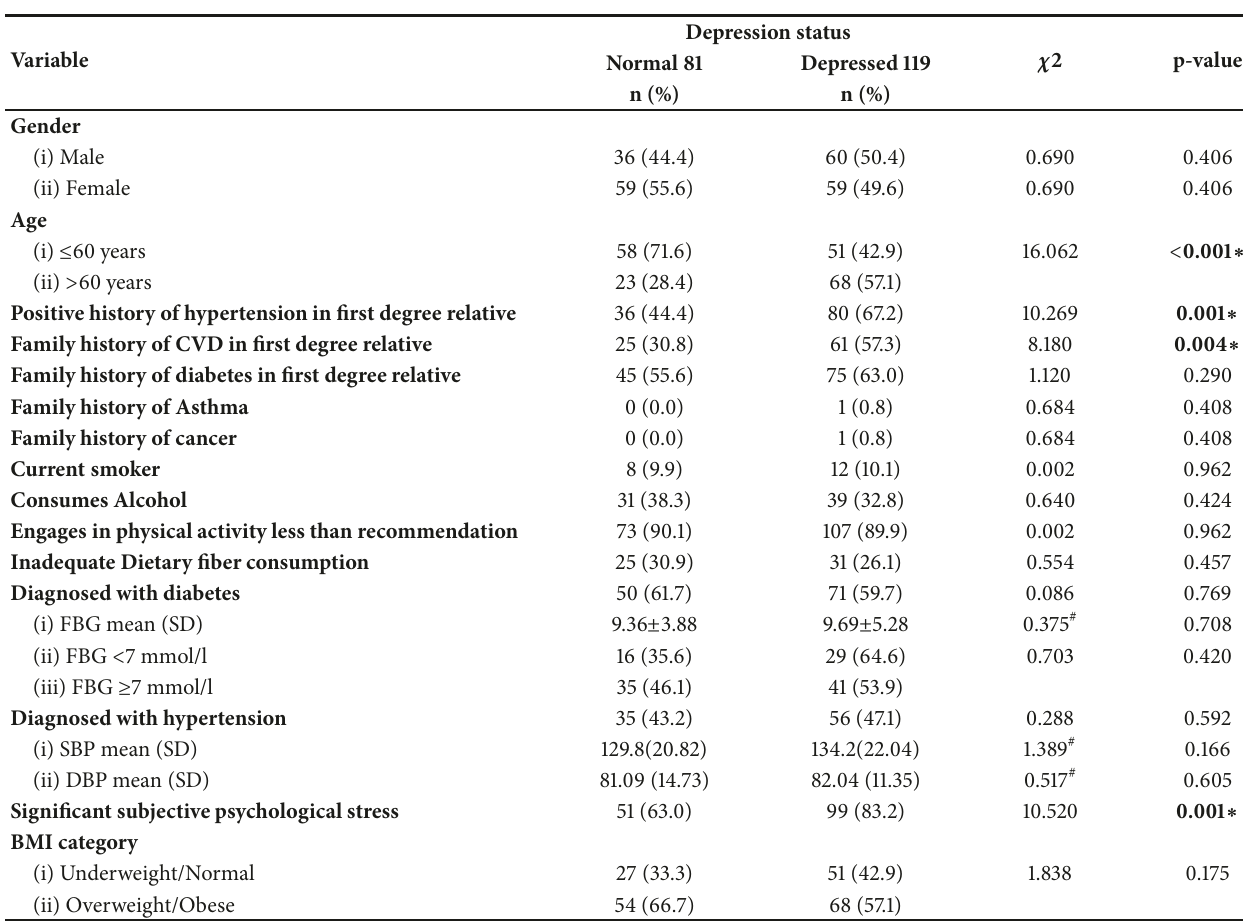
Table 3: Association of study variables with depression.